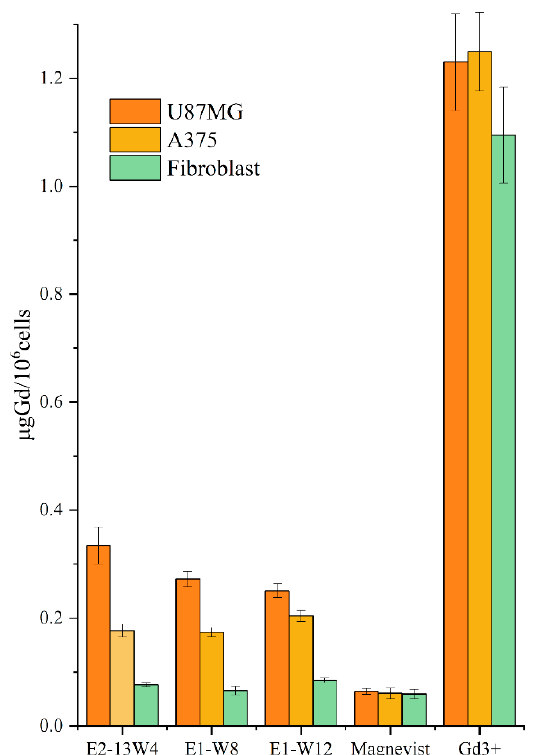
Figure 12. Gd 3+ weight content per 10 6 cells after 24 h incubation with the studied MBS proteins and control samples determined by ICP-AES. The results are presented as arithmetic means, and the error bars represent standard deviations ( n = 3). Table 8. Concentrations of the samples and their functional elements during exposure and the Gd accumulation ratio of tumour to normal cells.